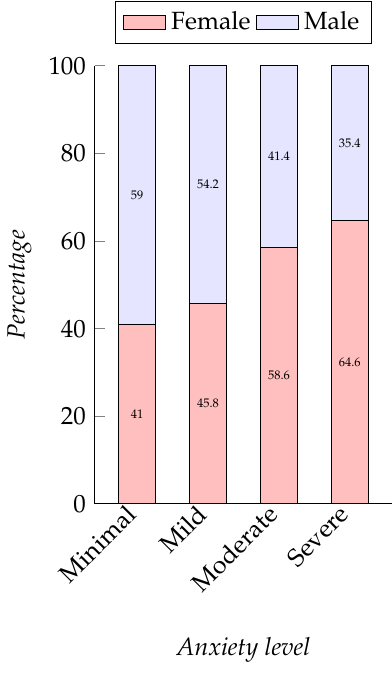
Figure 5. Participants’ gender and their level of